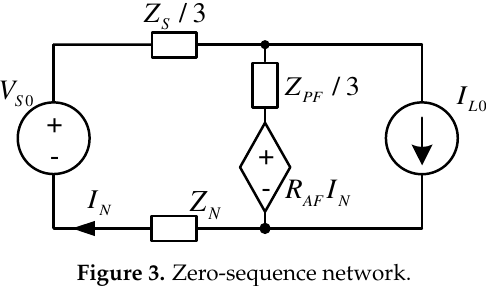
Figure 3. Zero-sequence